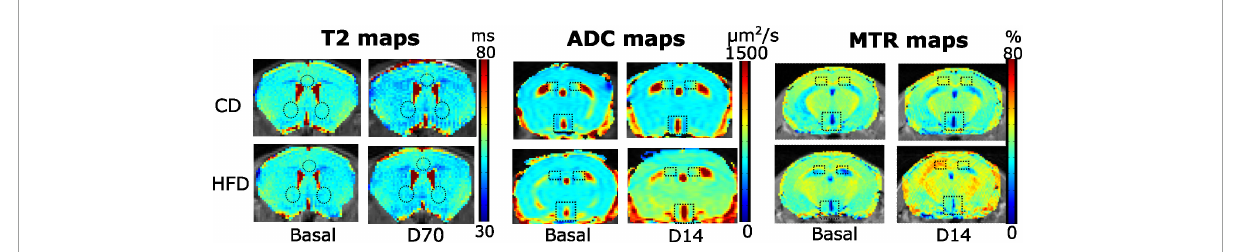
FIGURE2 Representative T2, ADC and MTR maps of control (top) or HFD-fed (bottom) male animals in different time points. T2 maps illustrate the T2 values of male animals in the brain slice containing the NAc (bottom circles) and ILA (top circle) regions, on basal (left) or D70 measurements. A slight shift to darker values can be appreciated in the D70 maps, both in SD and HFD mice. ADC maps show the corresponding coefficients of a male mouse in the slice containing the hypothalamus (bottom rectangle) or hippocampus (top squares), on the basal and D14 time points. A change to yellower/reddish colors can be seen in the HFD-D14 map. MTR plots depict the basal (left) and D14 (right) values on a male animal under SD (top), or HFD (bottom), on the slice containing the hypothalamus and hippocampus, with the corresponding ROIs. The HFD mouse images at day 14 have higher MTR values, and are slightly shifted to yellow-red colors. All maps are depicted for illustrative purposes